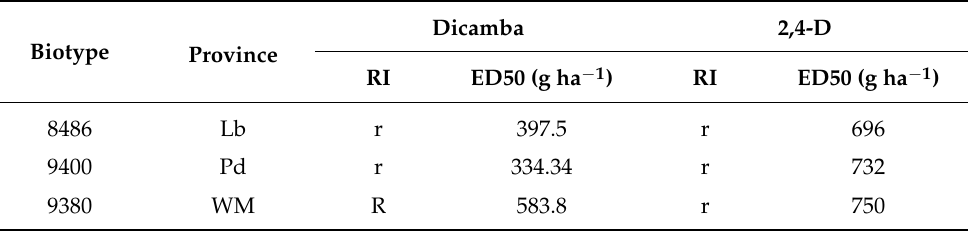
Table 4. Populations of cornflower resistant to synthetic auxins characterised by ED50 (effective dose causing 50% shoot fresh weight reduction in the treated plants) and resistance index (RI).